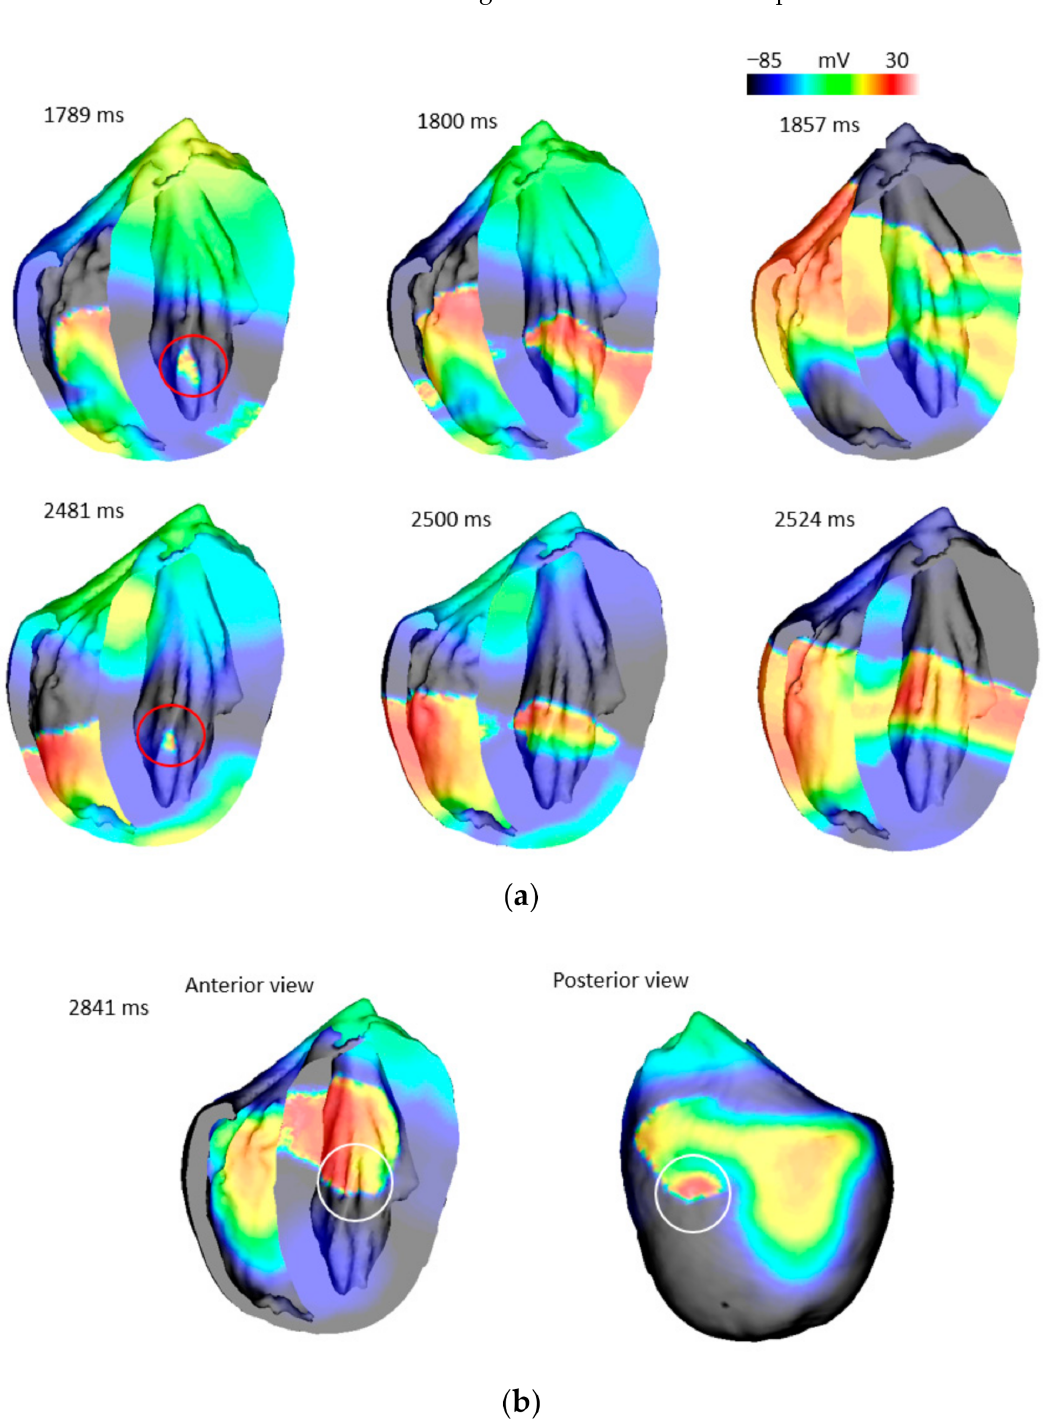
Figure 6. ( a ) The mode of the endocardial transmural micro-reentrant (inside the red circle) propagation; ( b ) Reentrant activation transmitted from endocardium to epicardium (inside the white